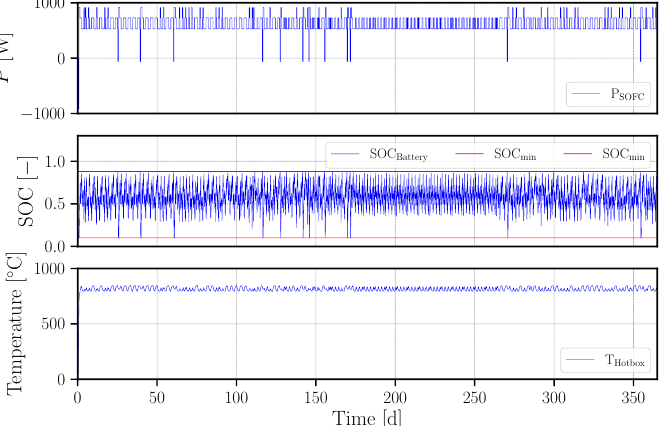
Figure 21. Exemplary annual simulation of the battery hybrid system with hot standby of a 1 kW el SOFC power generator, a 10 kWh battery and a 15 kWh/day electricity consumption indicating the electrical load, the state of the charge of the battery (SOC) and the temperature of the hotbox.